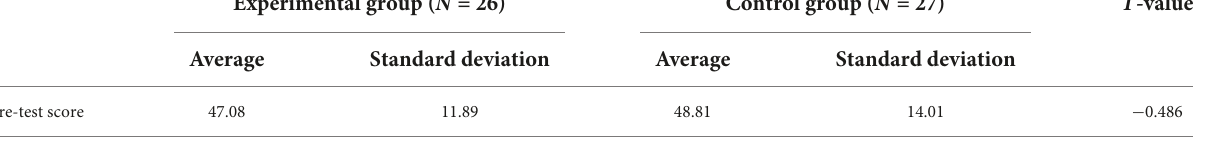
TABLE 1 The standard deviation of pretest results for learning effectiveness.